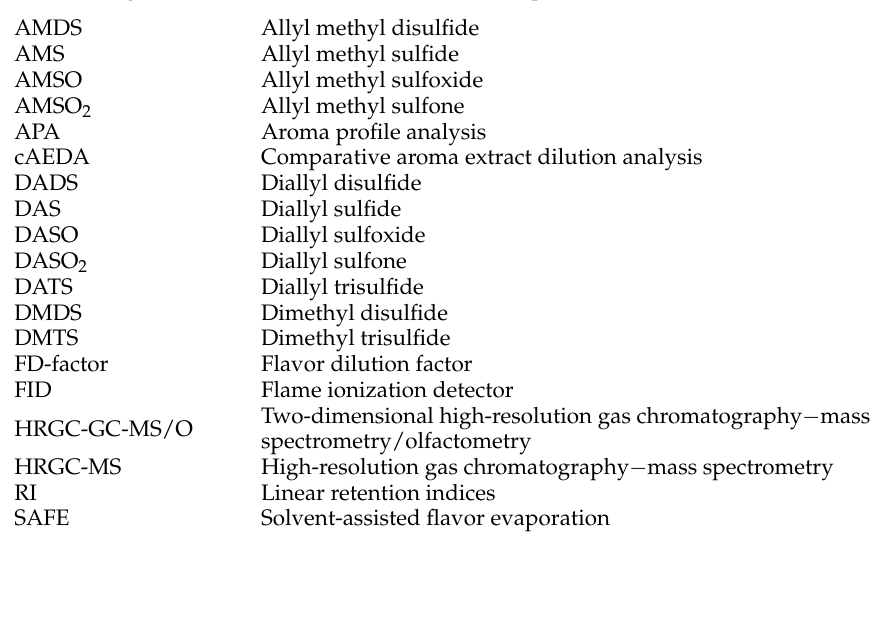
Figure S1: Aroma profiles of human milk samples of test persons a–f . The samples were collected at different times before and after ingestion of 3 g of raw garlic, Tables S1–S6: Dietary records of test persons a–f , Table S7: Time of sampling, garlic consumption and the respective amounts of the gathered